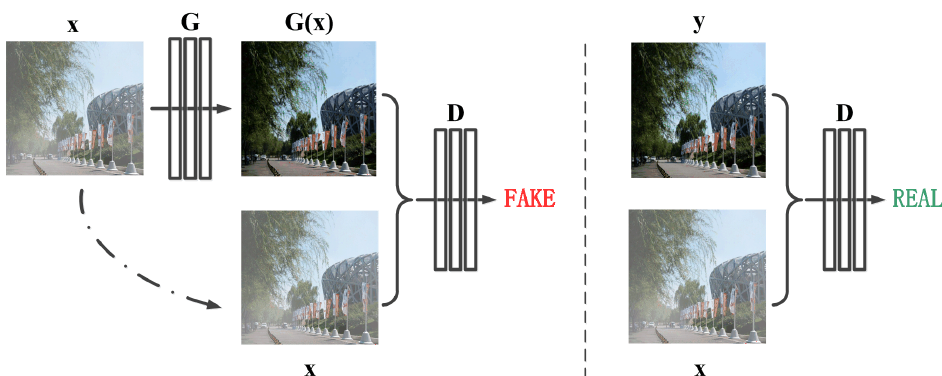
Figure 1. The architecture of the proposed framework. “G” denotes the generator and “D” denotes the discriminator. “x” is the input hazy image, “G(x)” is the reconstructed hazy-free image and “y” is the clear image. Unlike the unconditional GAN framework, both the generator and discriminator observe the input hazy image.